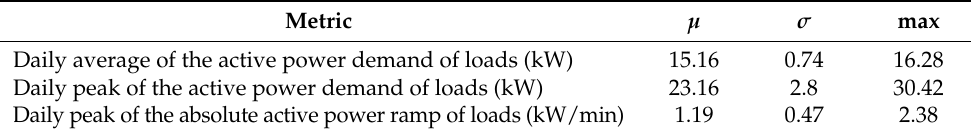
Table 6. Metrics of the load demand profile during May 2020. µ : average value, σ : standard deviation, max: maximum